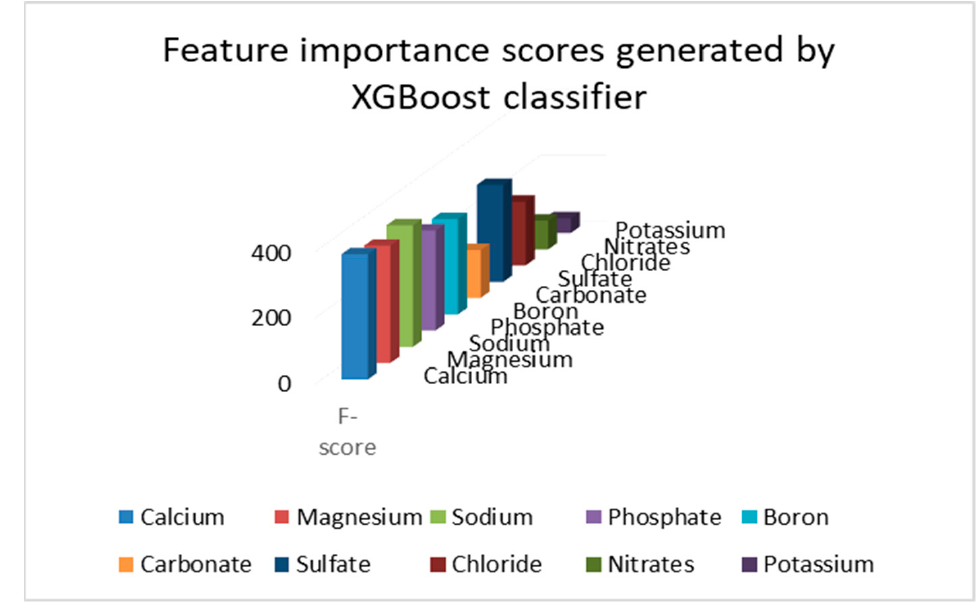
Figure 5. F-scores generated by the XGBoost classifier.